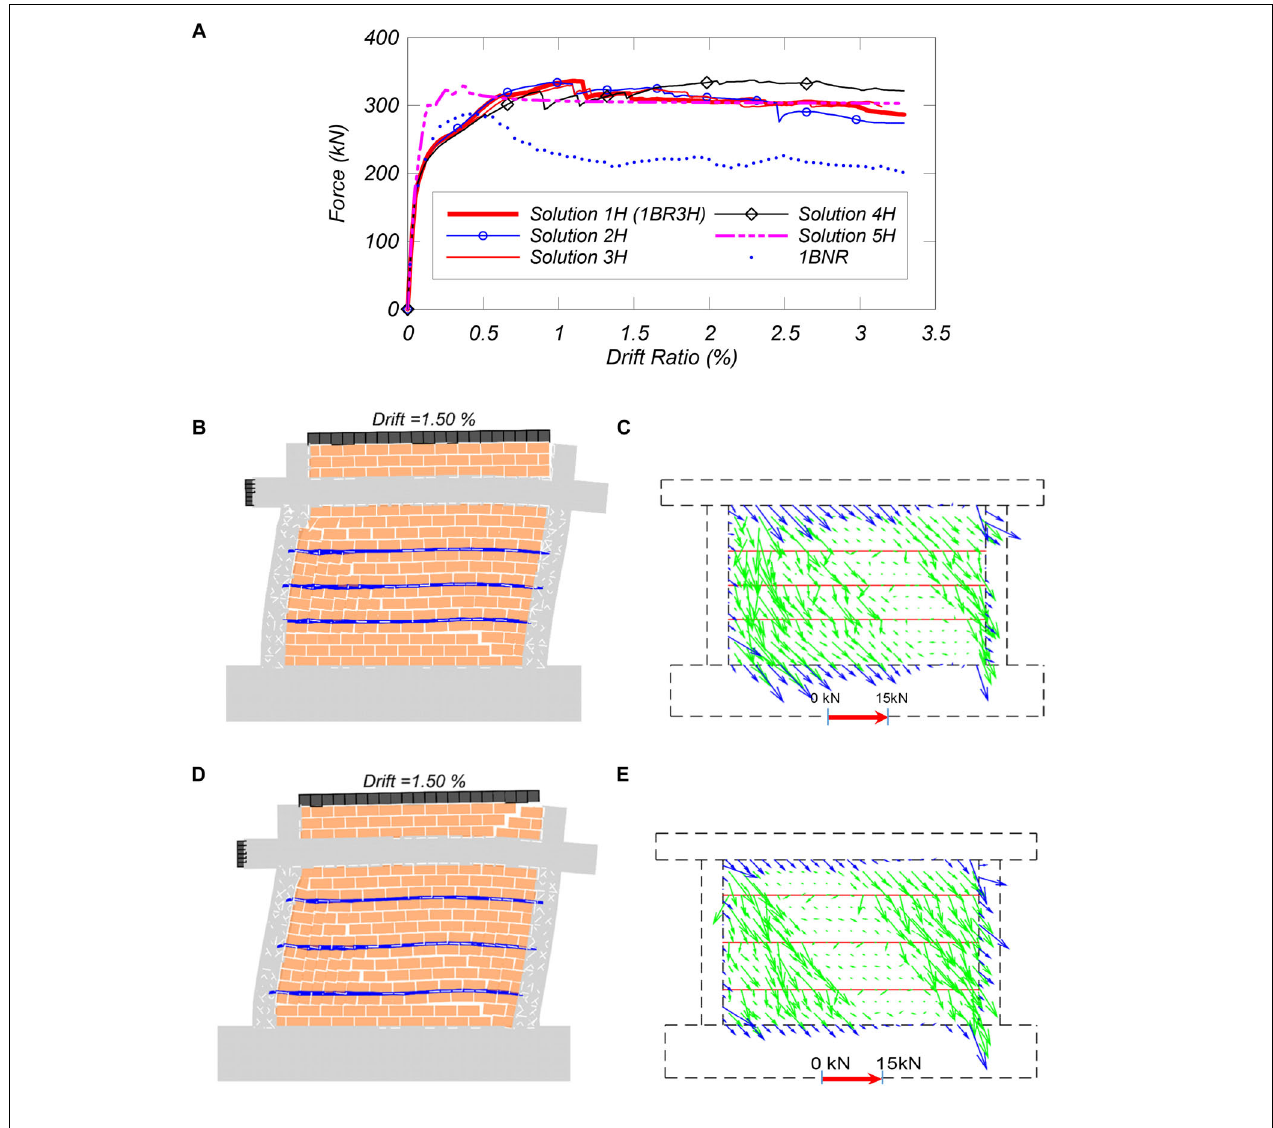
FIGURE 11 | The response of one-bay retrofitted model with a different number of horizontal NSM bars: (A) lateral force vs. drift ratio, (B) deformed shape of Solution 2H, (C) force distribution of Solution 2H (D) deformed shape of 1BR3H, and (E) force distribution of